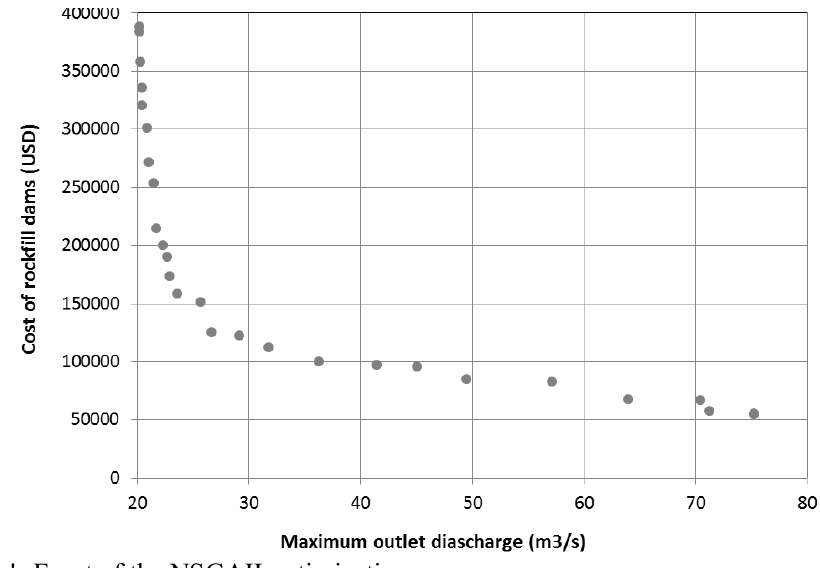
Figure 6 . Pareto's Front of the NSGAII optimization